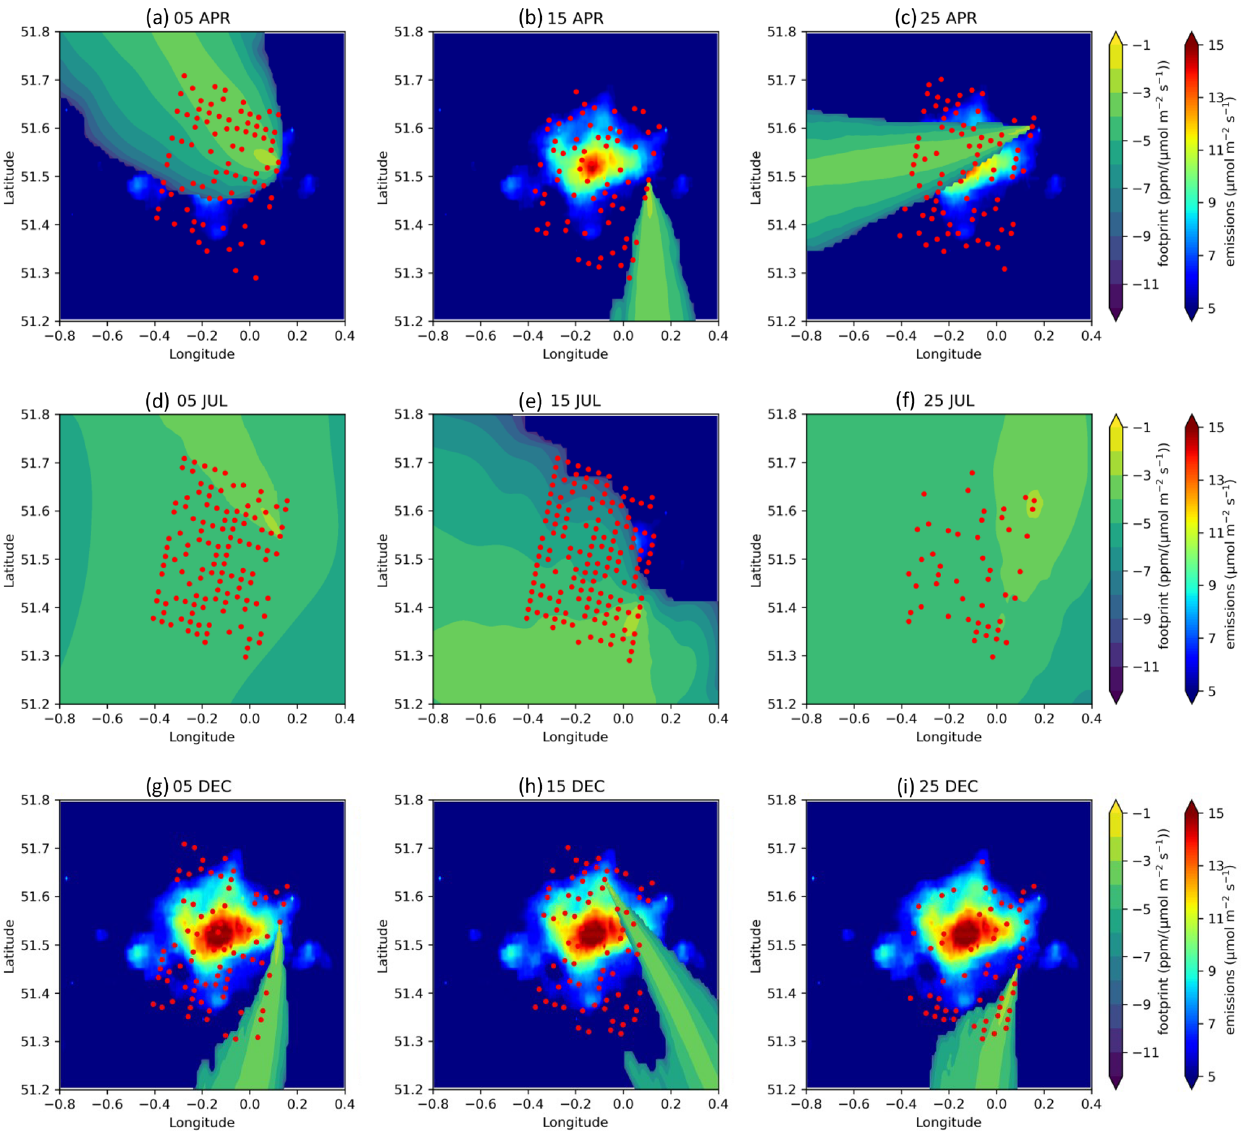
Figure A4. Same as Fig. A3 but for